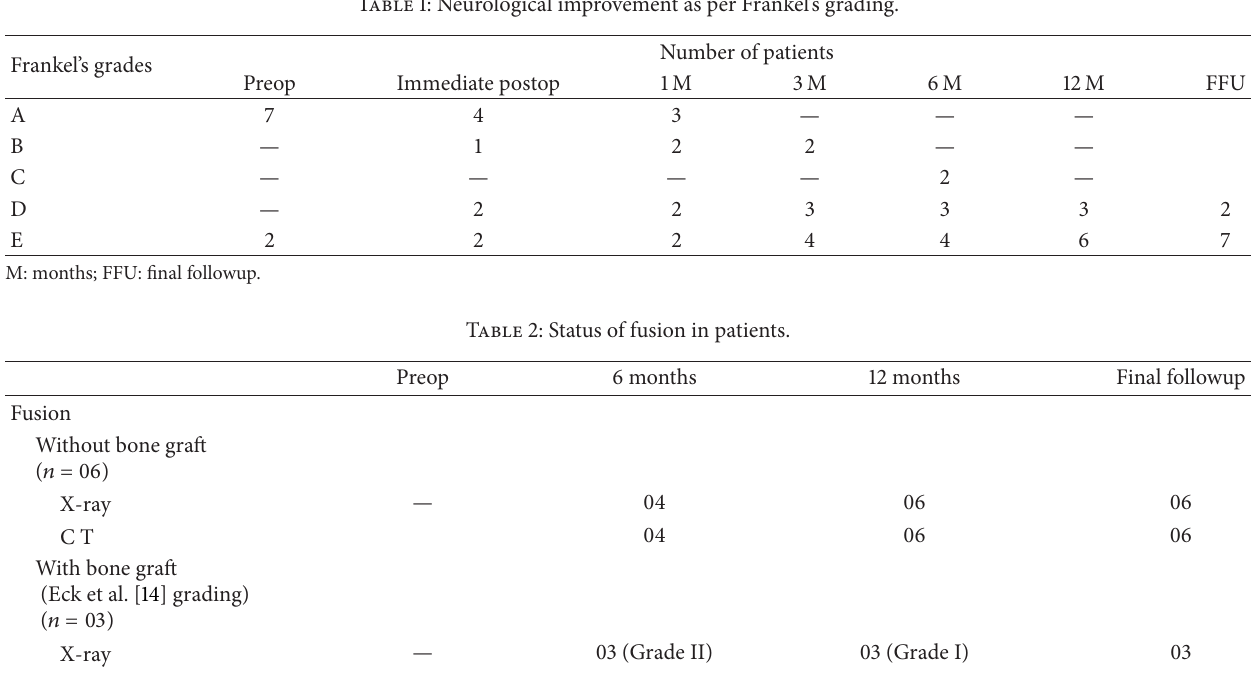
Table 1: Neurological improvement as per Frankel’s grading.